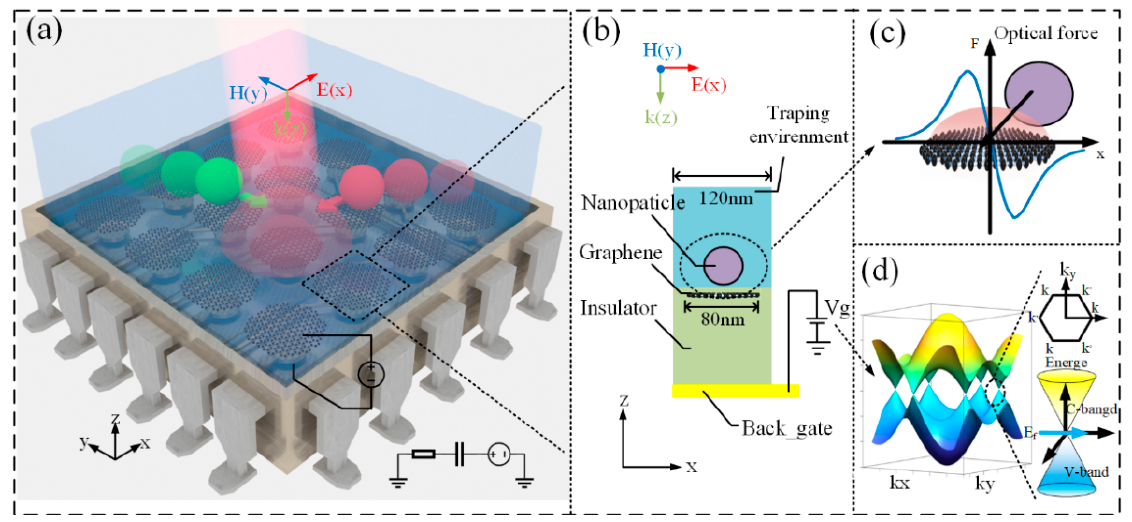
Figure 1. ( a ) 3D schematic diagram of Tunable graphene disks 2D plasmonic tweezers for trapping and transportation of nanoparticles. ( b ) Schematic of the cross-section of single graphene disc structure for optical trapping of nanoparticles. ( c ) MST optical forces on a dielectric nanosphere. ( d ) Band structure of graphene electrodes under a voltage bias.